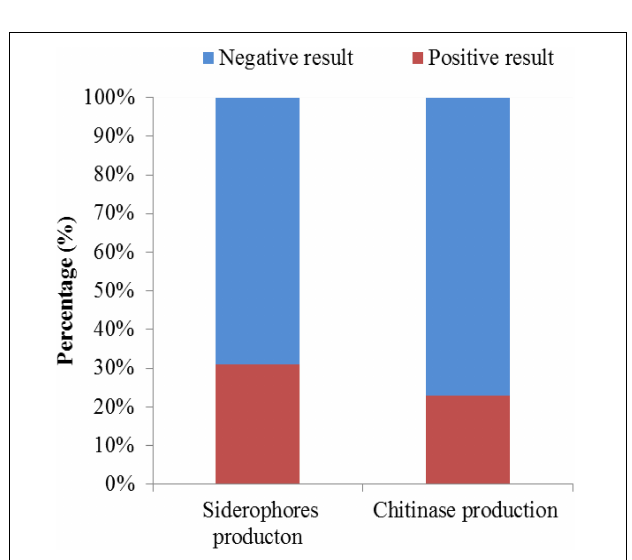
FIGURE 7 | Representation of antimicrobial activities by the endophytic actinomycetes isolated from T. roseus Schipcz. (a) biocontrol activity against F. oxysporum f.sp; (b) biocontrol activity against F. fulva (Cooke) Cif.; (c) biocontrol activity against A. solani ; (d) biocontrol activity against F. oxysporum ; (e) biocontrol activity against V. malicola ; (f) biocontrol activity against V. mali ; (g) biocontrol activity against S. enteritidis ; (h) biocontrol activity against B. cereus ; (i) biocontrol activity against S. aureus ; and 39 and 40 represent T4SB028 ( S. armeniacus ) and T4SB030 ( S. polyantibioticus ), respectively.